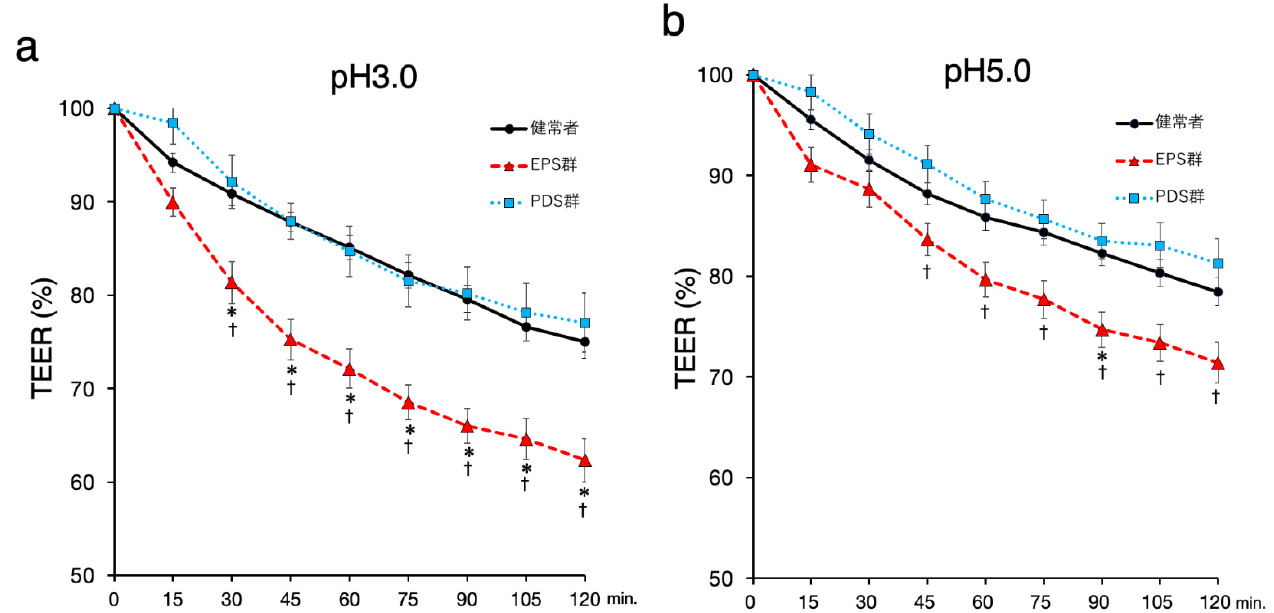
Figure 2. The changes of duodenal TEER in the different acidity of the exposure. Changes in the TEER are expressed as percentages relative to the initial values. Each plotted data point represents the mean ± standard deviation. ( a ) The duodenal TEER with the exposure to pH3 acid solution. ( b ) The duodenal TEER with the exposure to pH5 acid solution. Black circle and line: the healthy controls ( n = 23), red triangle and dashed line: the EPS patients ( n = 16), blue square and dotted line: the PDS patients ( n = 11). TEER: transepithelial electrical resistance, EPS: epigastric pain syndrome, PDS: postprandial distress syndrome. p < 0.05, significant difference at each time point using Tukey–Kramer test; *, control vs. EPS; †, PDS vs. EPS.